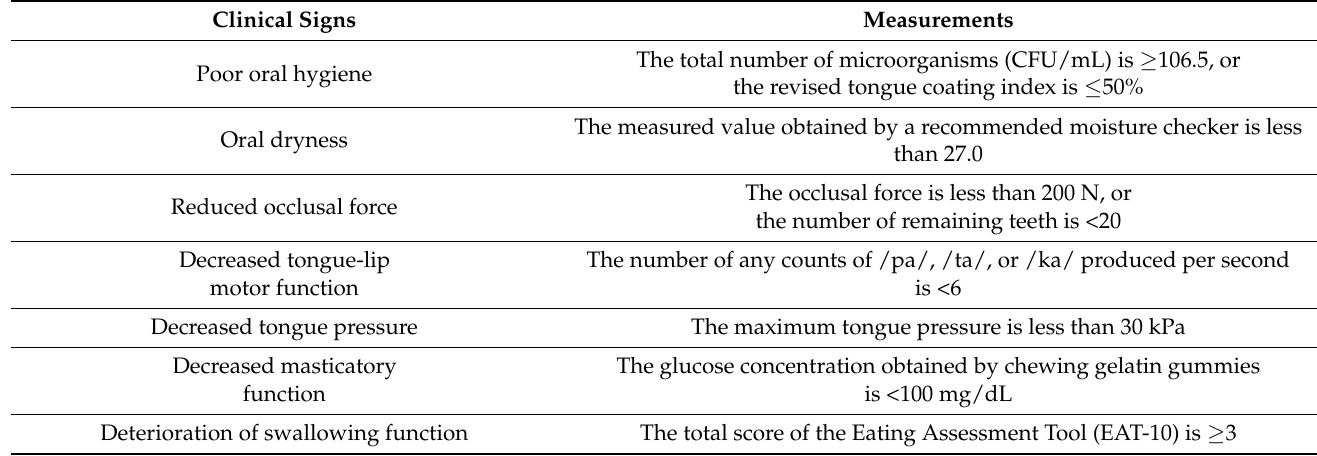
Table 5. Measurements of clinical signs/symptoms of oral hypofunction.